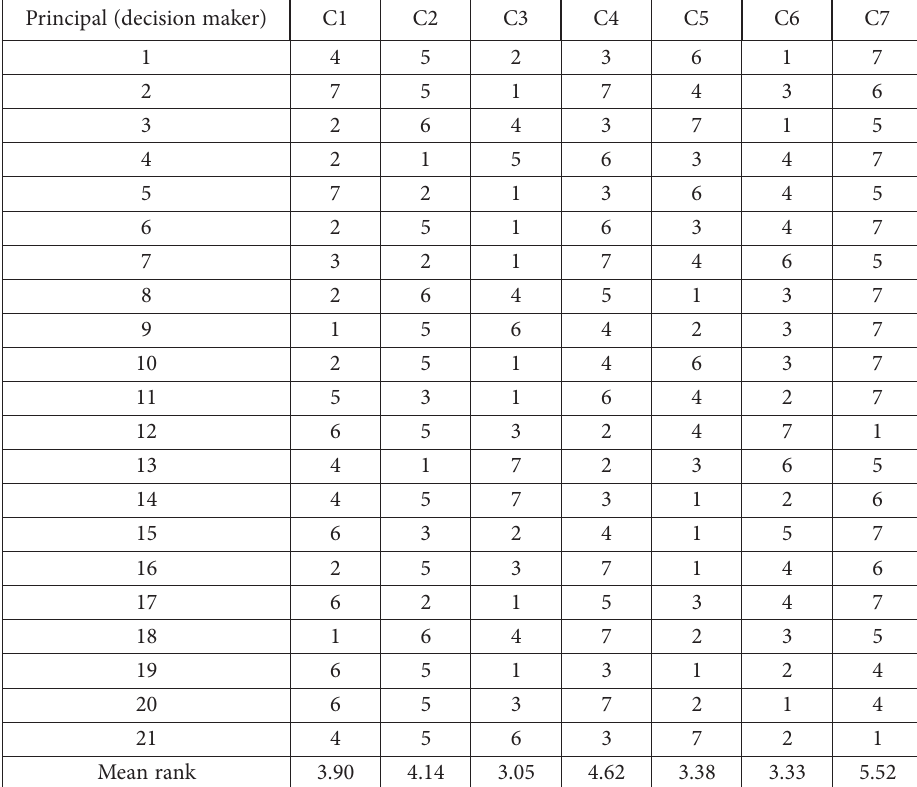
Table 2. Rank values for the tested criteria (the meaning of the criteria has been provided under Table 1) Principal (decision